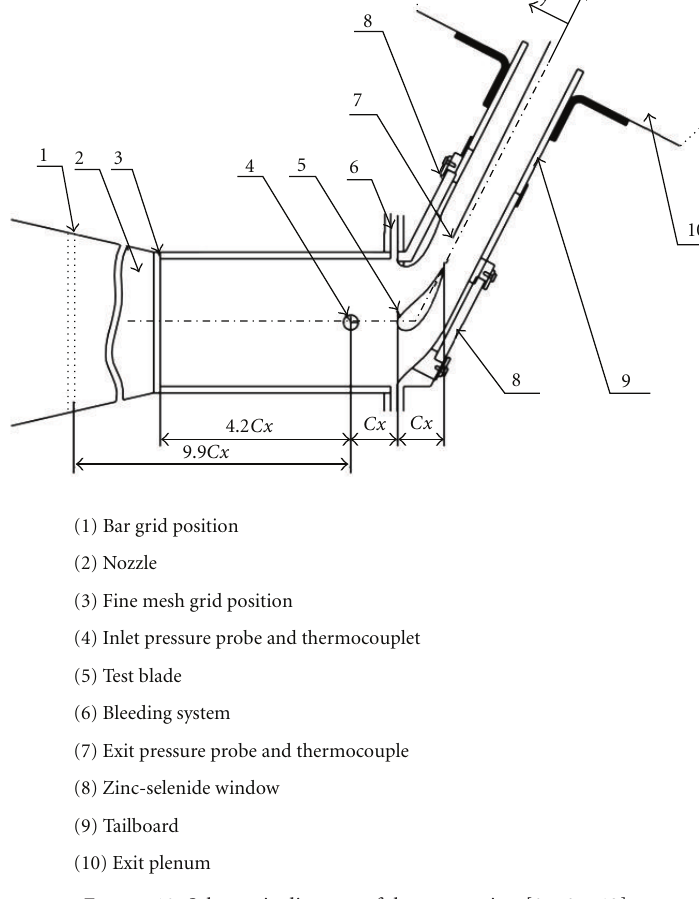
Figure 12: Schematic diagram of the test section [27, 37–40].